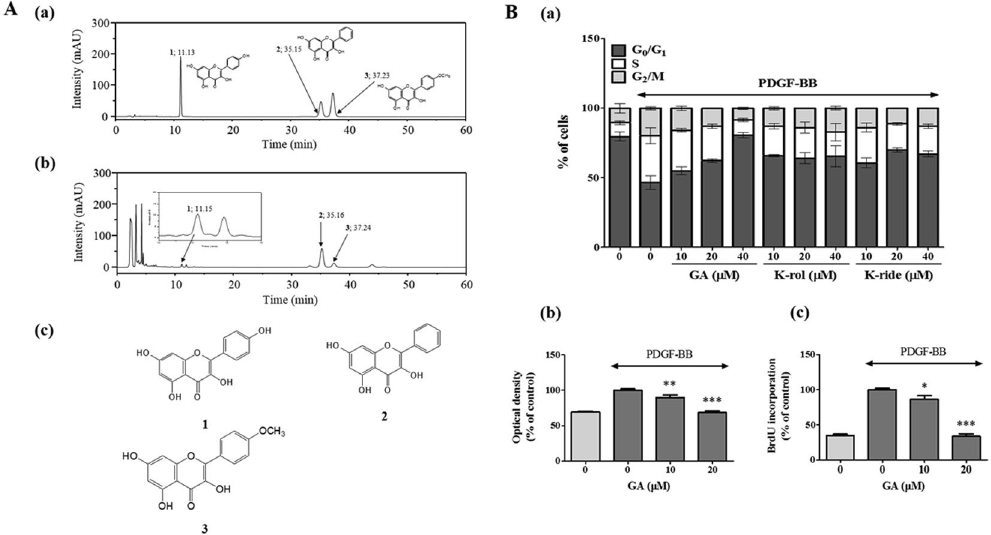
Figure 3. High-performance liquid chromatography (HPLC) analysis of the major compounds in the AO extract and determination of the active components. ( A ) HPLC chromatogram at 330 nm of a standard mixture including kaempferol (1, K-rol), galangin (2, GA), and kaempferide (3, K-ride) (a), and the AO extract prepared from a dry powder (b); the chemical structures are shown in (c). ( B ) The effects of GA, K-rol, and K-ride on cell cycle progression (n = 3) (a), and the effects of GA on VSMC proliferation (b) and DNA synthesis (c) (n = 4). The results were analyzed using densitometry, with the values representing the percentage relative to the PDGF-stimulated controls. The results are an average of three or more similar, independent experiments and are expressed as the mean ± SEM. Significant differences relative to the controls are indicated by asterisks: * P < 0.05, ** P < 0.01, *** P <